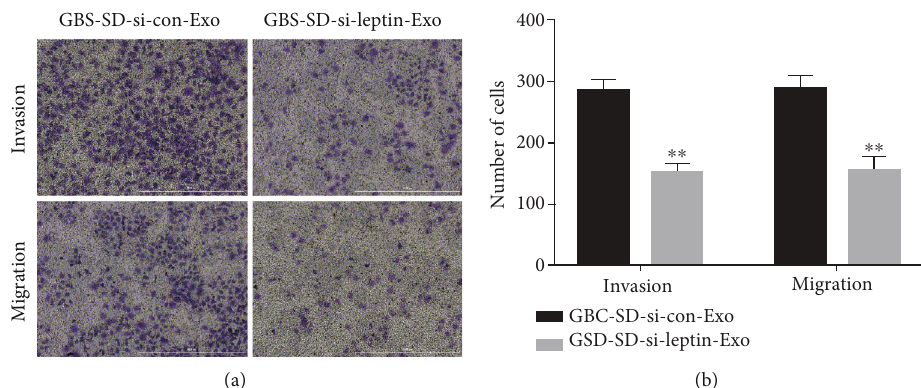
Figure 3: M2 macrophage induced by exosomal promotes invasion and migration of GBC-SD cells through leptin transfer. Transwell assay to detect invasion and migration of GBC-SD cell cocultured with macrophage treated with exosomes form si-control or si-leptin-transfected GBC-SD cell. Invasion and migration of GBC-SD cell were quanti fi ed. Data in (a) is representative of three independent experiments; the P value was determined by Student ’ s t